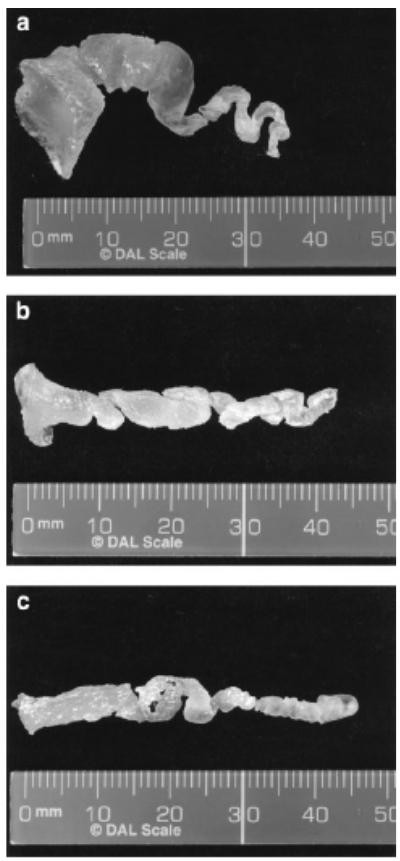
Fig. 2 Examples of acrylic casts (a) Neck and tortuous proximal cystic duct, (b) M-shaped loop followed by spiral course, and (c) Elongated cystic duct containing a small pigment stone (12)